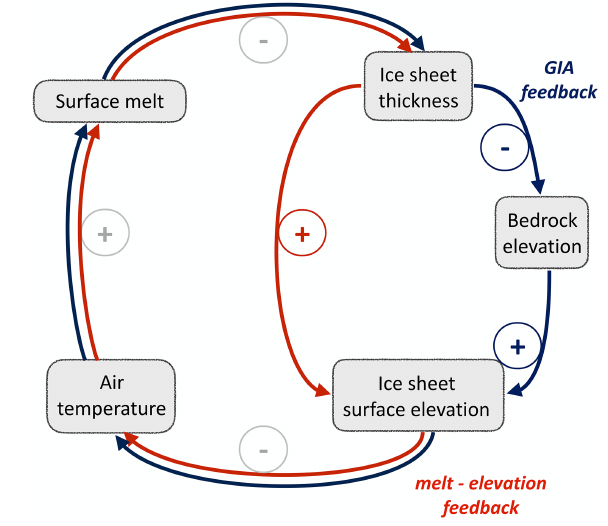
Figure 1. Interacting feedback loops for the proposed glacial iso- static adjustment feedback (GIA feedback). The red part indicates the melt–elevation feedback: higher air temperatures lead to de- creasing climatic mass balance. This in turn leads to a decreasing ice thickness and in consequence to a decreasing ice surface ele- vation. If the surface elevation decreases, the air temperature rises due to the atmospheric lapse rate. This further decreases the cli- matic mass balance and leads to a positive (enhancing) feedback cycle. The timescale of this feedback cycle is driven by changes in the climate and is typically comparably fast. The blue part shows the counteracting mechanism of the ice load–bedrock uplift feed- back. The decreasing ice thickness reduces the load on the bedrock, which leads to isostatic adjustment and therefore an uplift of the bedrock elevation. This mechanism partly counteracts the decrease in ice surface elevation and thus mitigates further increase in tem- perature. The timescale of this feedback loop depends on the rate of ice retreat and on the viscosity of the upper Earth